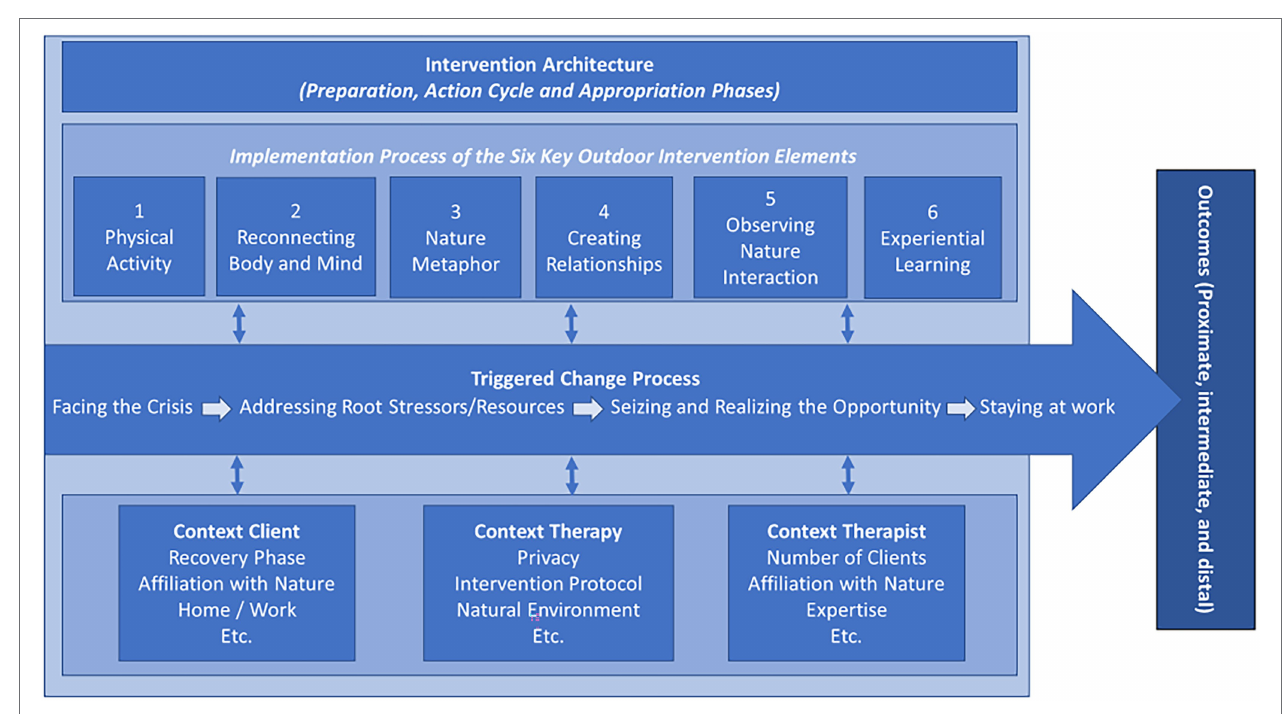
FIGURE 1 | Intervention and evaluation model of outdoor therapy for employee